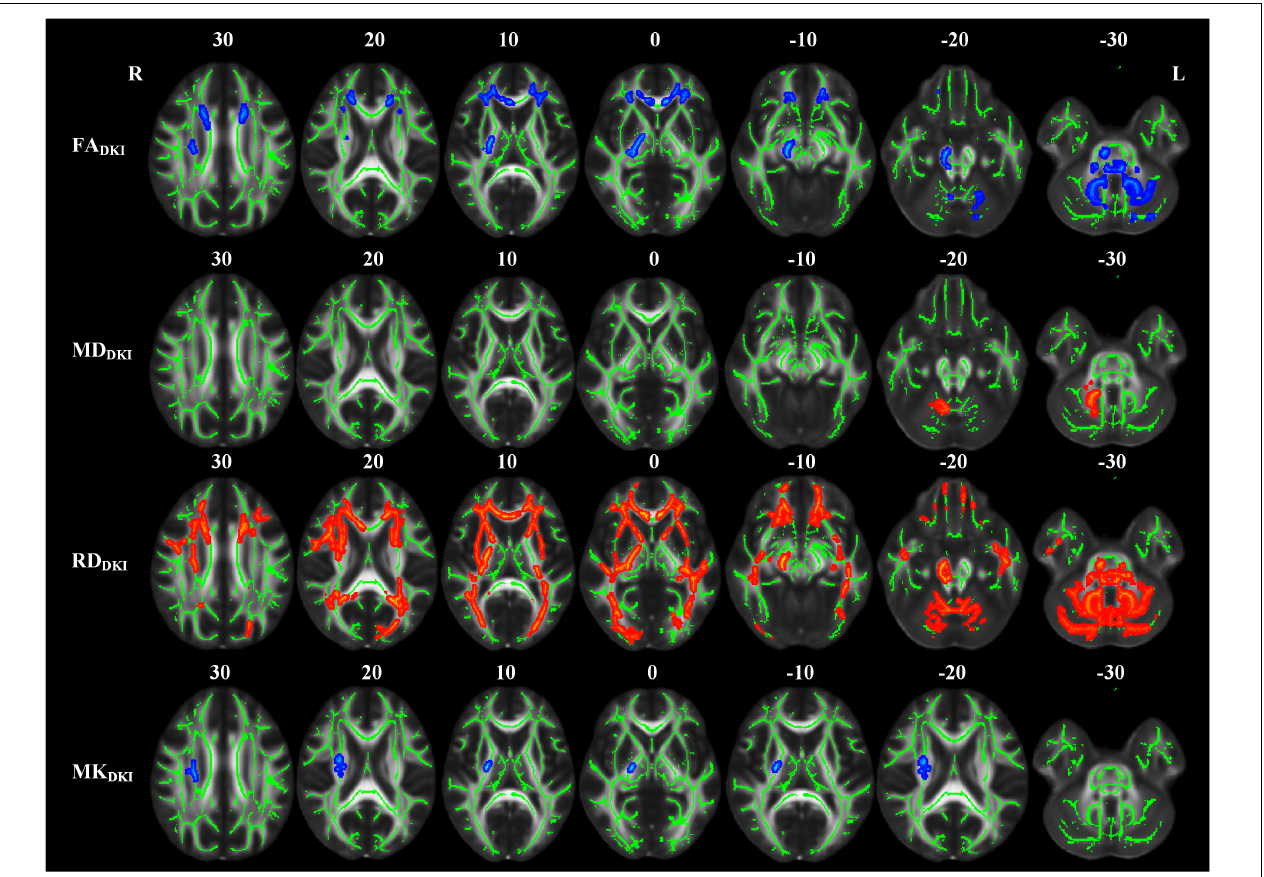
FIGURE 5 | TBSS analyses showed abnormal white matter tracts in the RPI group with DKI-derived parameters. Red indicated white matter tracts with significantly increased parameter values and blue indicated white matter tracts with significantly decreased parameter values. Green represented the mean FA skeleton of all subjects. L and R, left and right; FA, fractional anisotropy; MD, mean diffusivity; RD, radial diffusivity, TBSS, tract-based spatial statistics; DKI, diffusion kurtosis